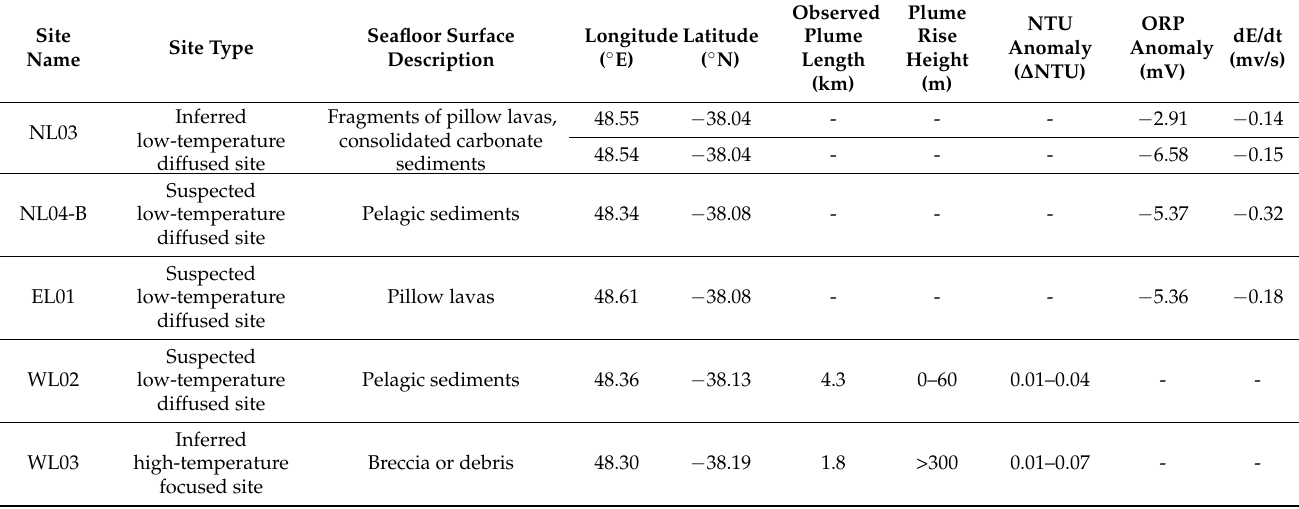
Table 1. Information of water column anomaly and seafloor